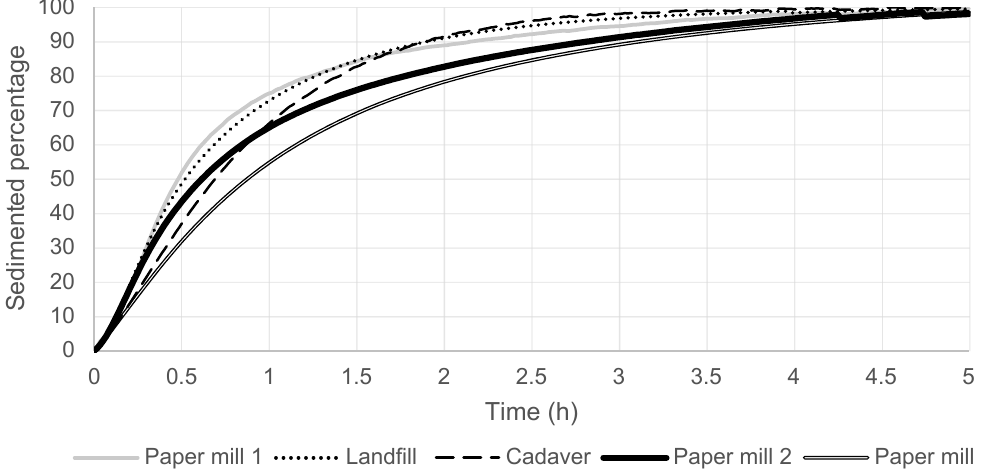
Figure 8. Sedimentation capacity of the sulfur particles measured with a sedimentation column.